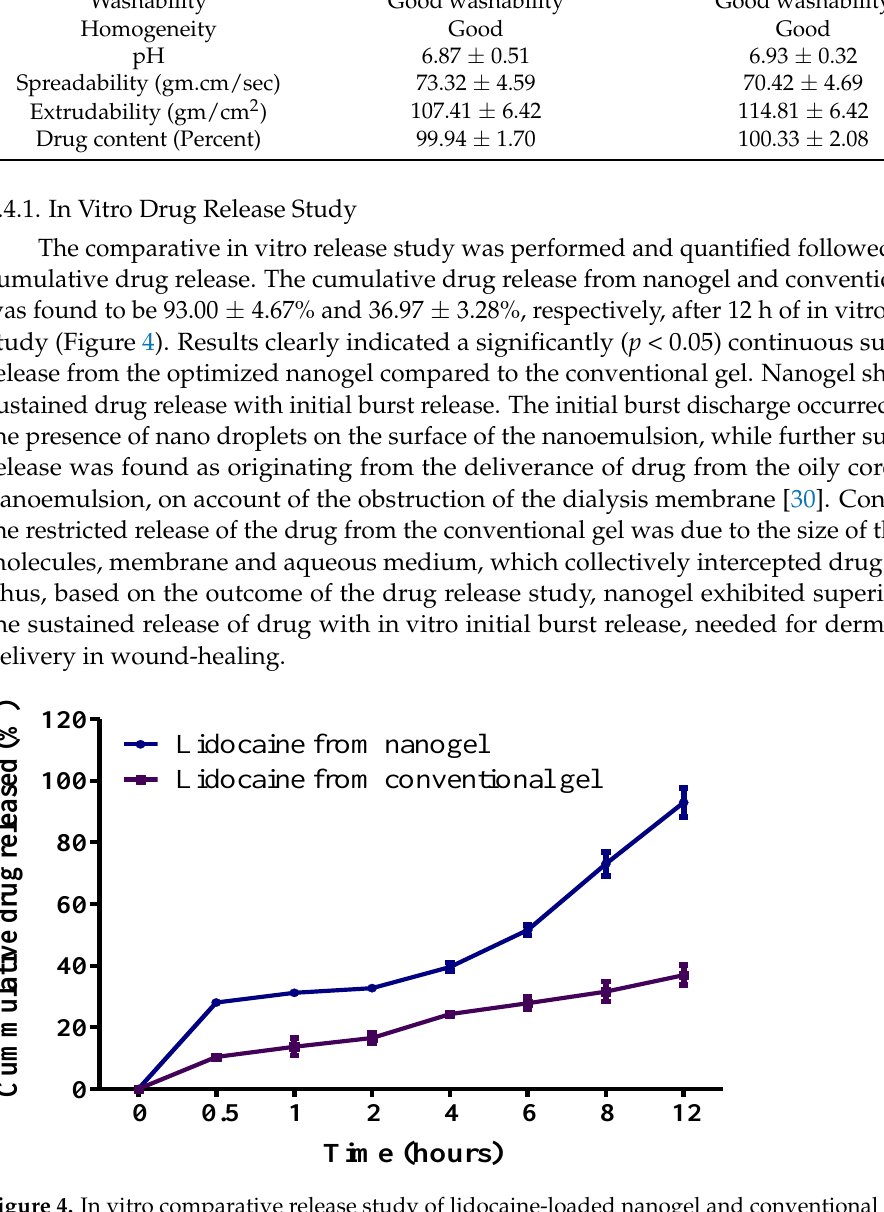
Figure 4. In vitro comparative release study of lidocaine-loaded nanogel and conventional gel.